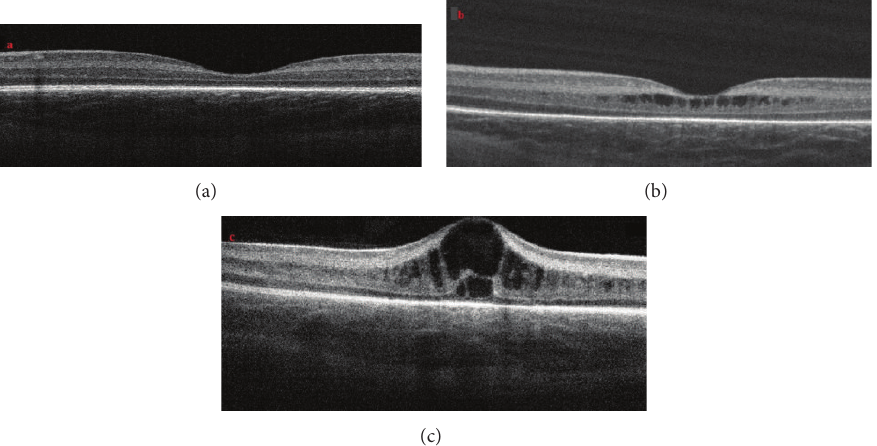
Figure 1: Examples of OCT images that demonstrate grade of cystoid macular edema. (a) Patient with no cystoid macular edema. (b) Patient with one or more cysts with no changes in the foveal contour. (c) One or more cysts with changes in the foveal